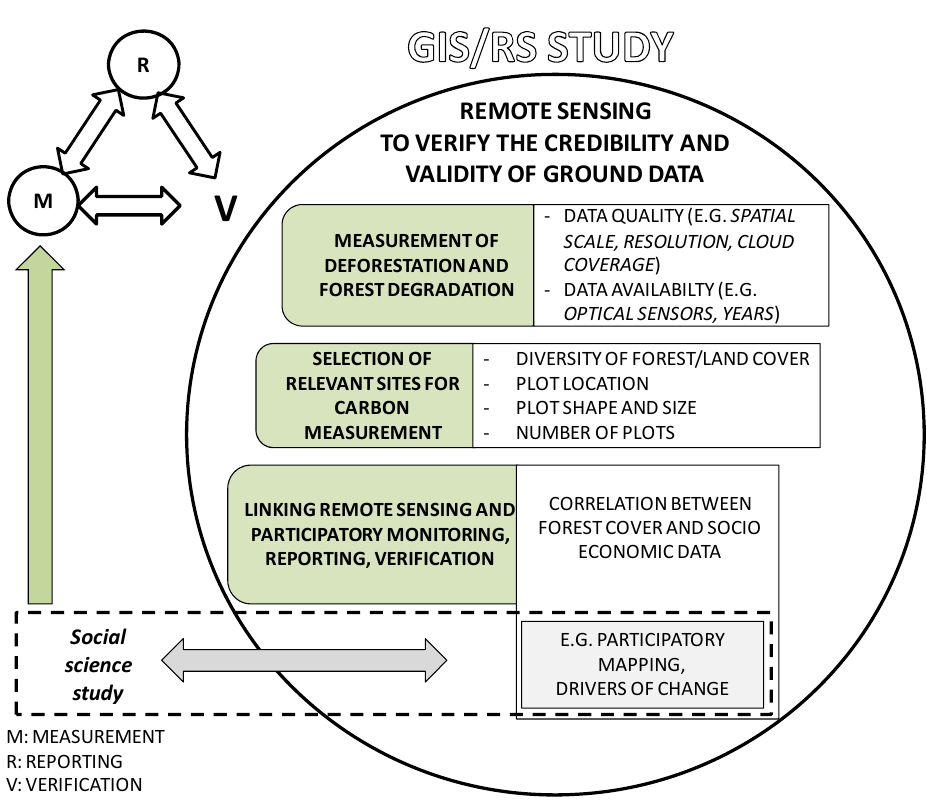
Figure 4. The remote sensing research